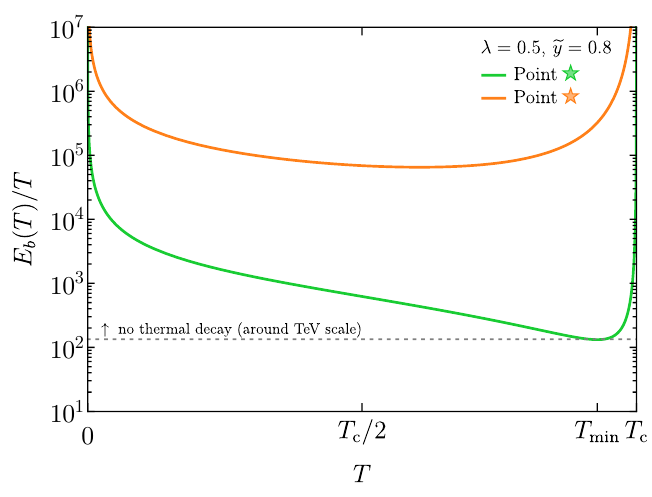
Figure 5 . Temperature dependence of the exponent for the probability of thermal decay, given by the ratio of free energy of the bubble E b ( T ) and temperature as in eq. (3.14). The two curves corre- spond to the two points of the parameter space marked with orange and green stars in (cid:12)gure 6. The orange line corresponds to a case where the false vacuum is stable (in our case, E b ( T ) =T (cid:29) 140) for all temperatures. For the green line, instead, the minimum of E b ( T ) =T at T min is below the thresh- old and the green point of (cid:12)gure 6 can be considered unstable against thermal decay throughout the thermal history of the Universe. It can be seen for both cases that, as T approaches T c (de(cid:12)ned in eq. (3.6)), the energy di(cid:11)erence between the two vacua vanishes and the decay rate goes to